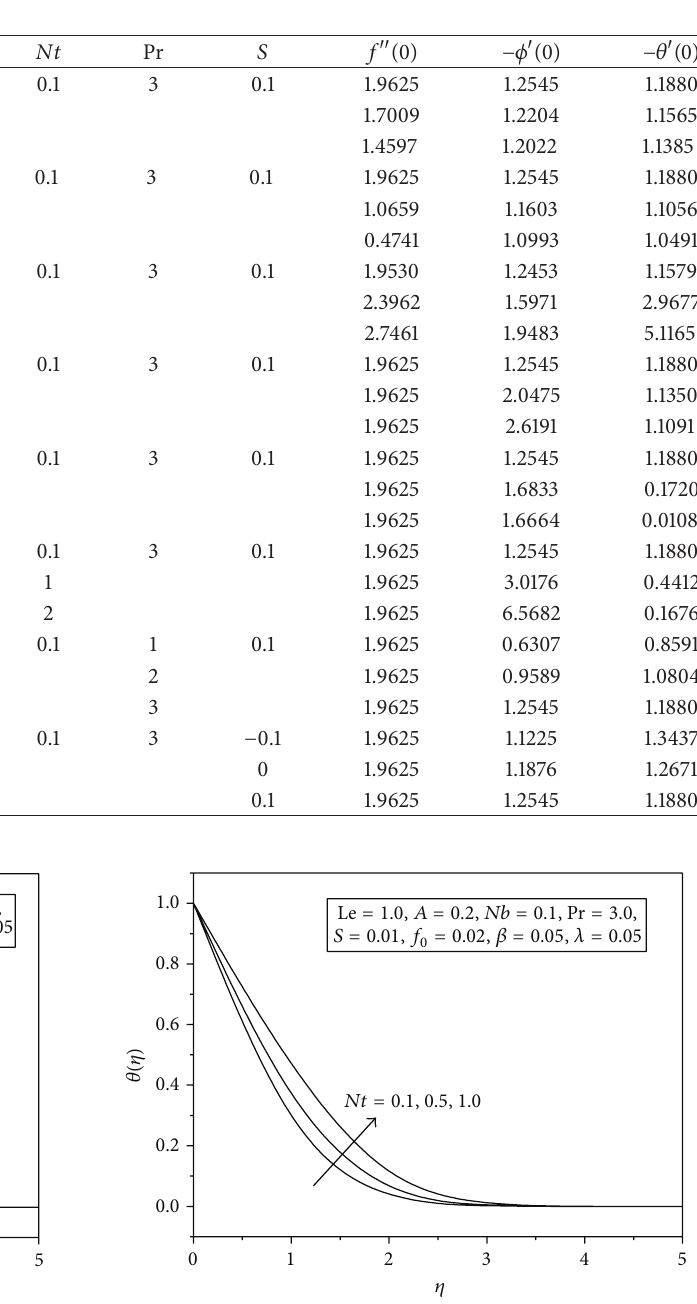
Figure 10: Concentration profile for different values of 𝑁𝑏 . Figure 11: Temperature profile for different values of 𝑁𝑡